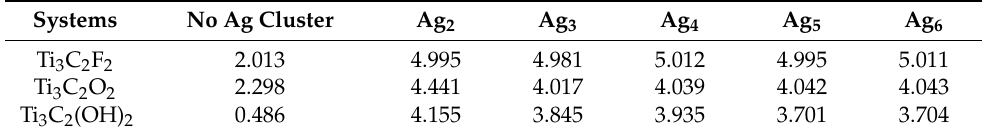
Table 2. MXene–MXene interlayer spacings (Å) for different Ag clusters.